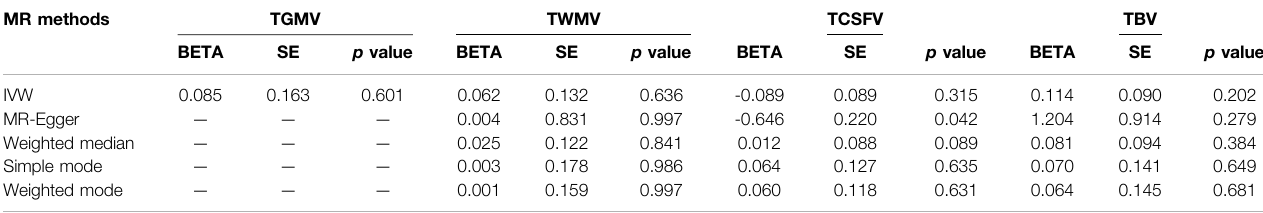
TABLE 1 | Results of the causal effect of TBVMs on SCZ risk. MR methods